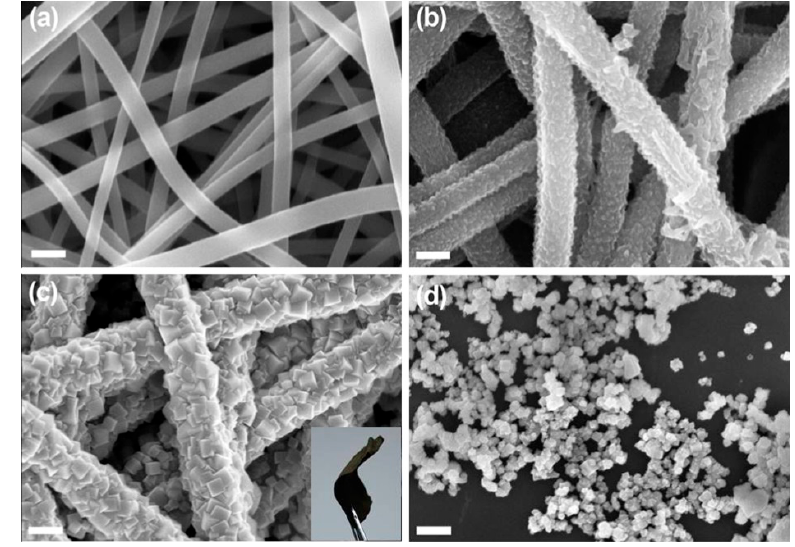
Figure 6. Field Emission Scanning Electron Microscope (FESEM) images of ( a ) electrospun carbon nanofibers, ( b ) NF-0.02, ( c ) NCNF-0.02@Co 3 O 4 -0.2 fiber membranes, and ( d ) Co 3 O 4 powder. Inset (c)